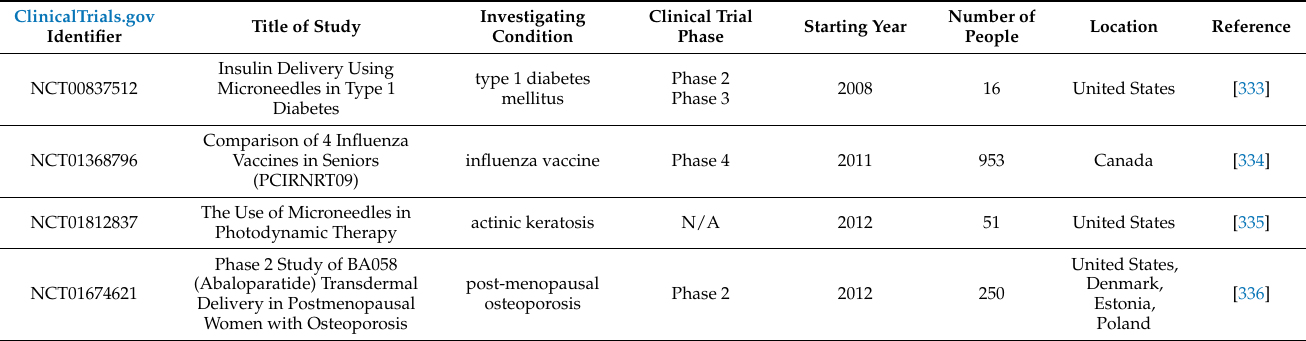
Figure 13. ( A ) Comparative percentage of completed MN clinical trials on ClinicalTrials.gov database. In total, 76 clinical trials data were found in distinct phases from the database. Information accessed on 21 February 2021 at www.clinicaltrials.gov, and ( B ) the number of issued US Patents for MN per year from 2000 to 2020. A total of 252 MN patents are available on the database. Information accessed on 21 February 2021 at http://patft.uspto.gov/. Table 4. List of completed clinical trials in MN technology. Information collected from the ClinicalTrials.gov database (Information accessed on 21 February 2021 at www.clinicaltrials.gov).